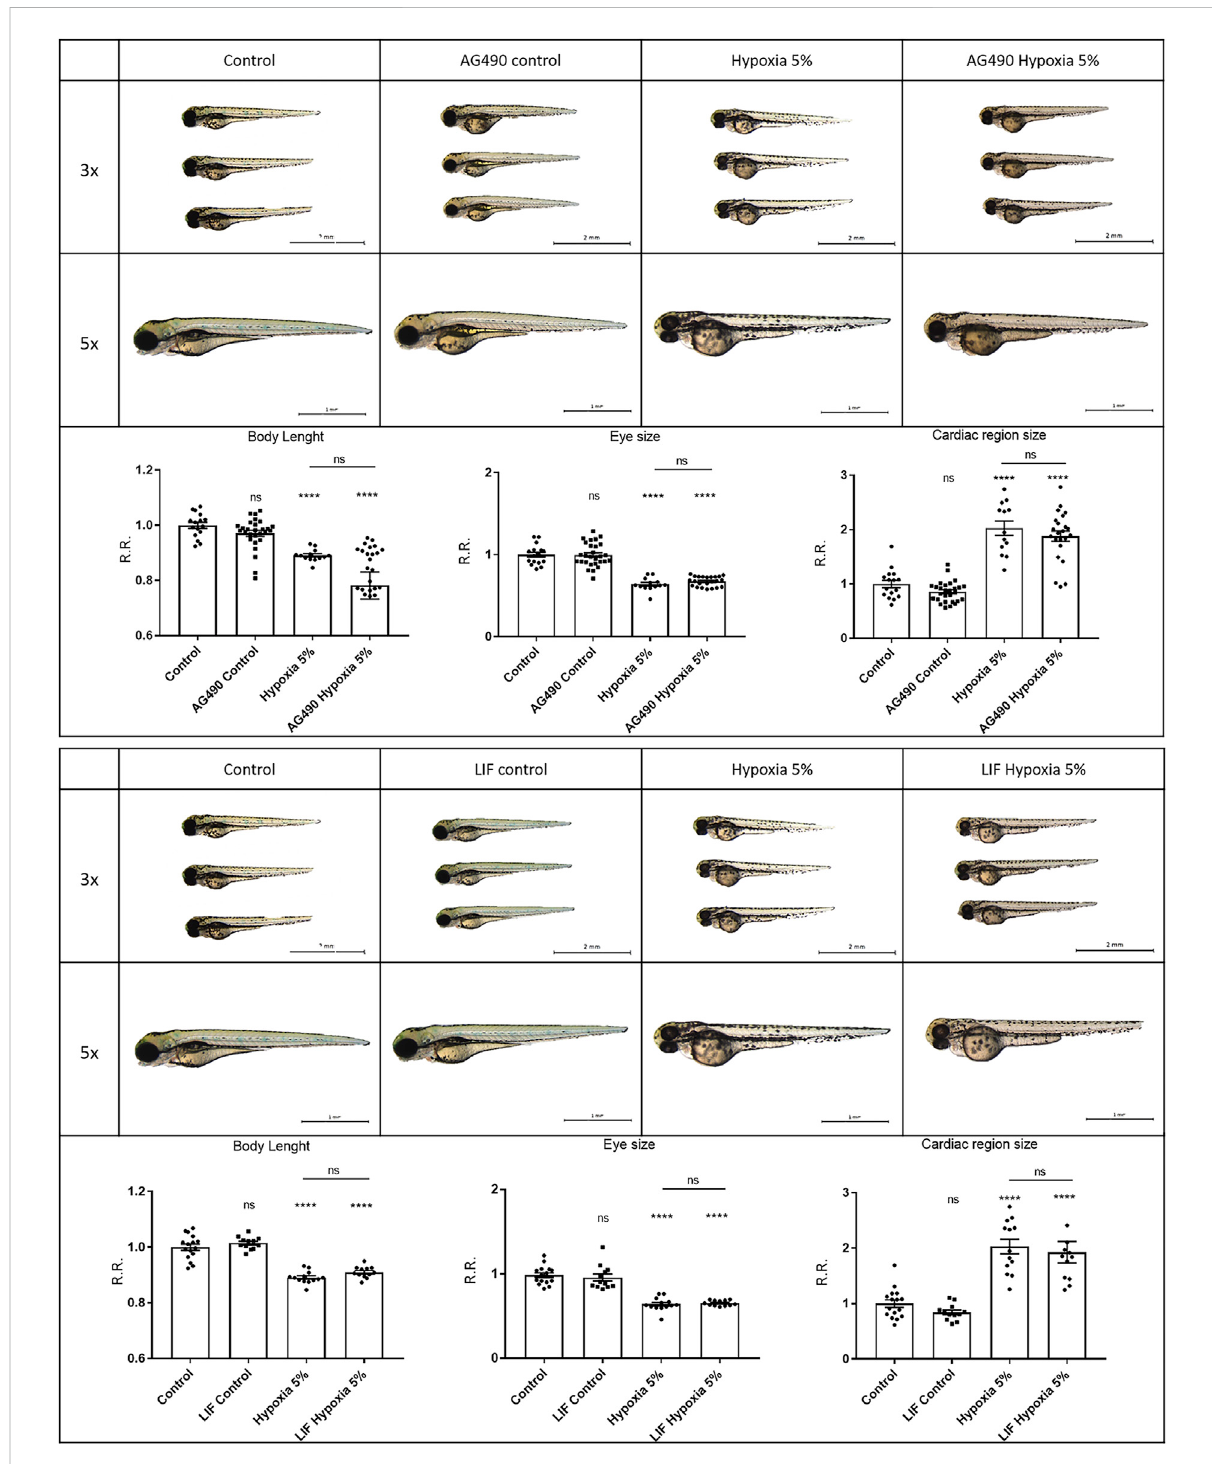
FIGURE 5 Stat3 signalling modulation does not rescue FGR anomalies. Downregulation of Stat3 signalling with 50 μ M AG490 inhibitor does not rescue body length, eye size and cardiac morphology under hypoxia. Upregulation of Stat3 signalling with 20 μ M LIF agonist does not rescue body length, eye size and cardiac morphology underhypoxia. All embryos, at3 dpf, are displayed in lateral view, anterior to the left. Sample size: n = 15; **** = p < 0.0001; ns = not signi fi cant; R.R. = Relative Ratio. Test: One-way ANOVA followed by Tukey ’ s